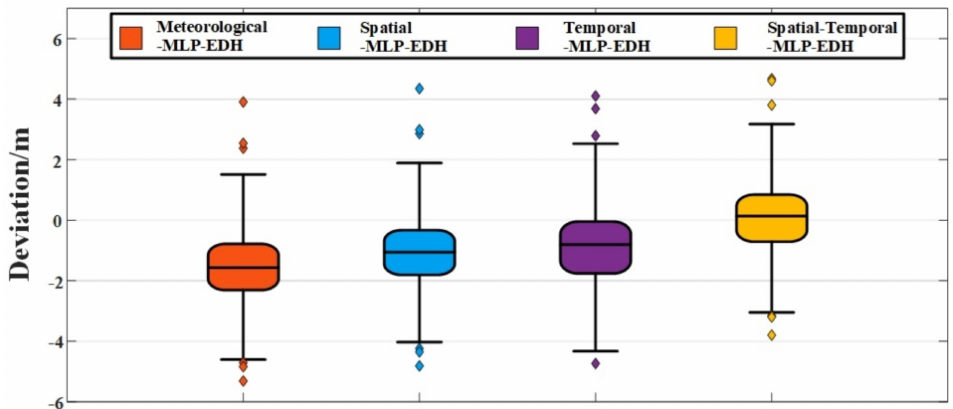
Figure 6. Generalization performance of the EDH prediction models based on MLP.